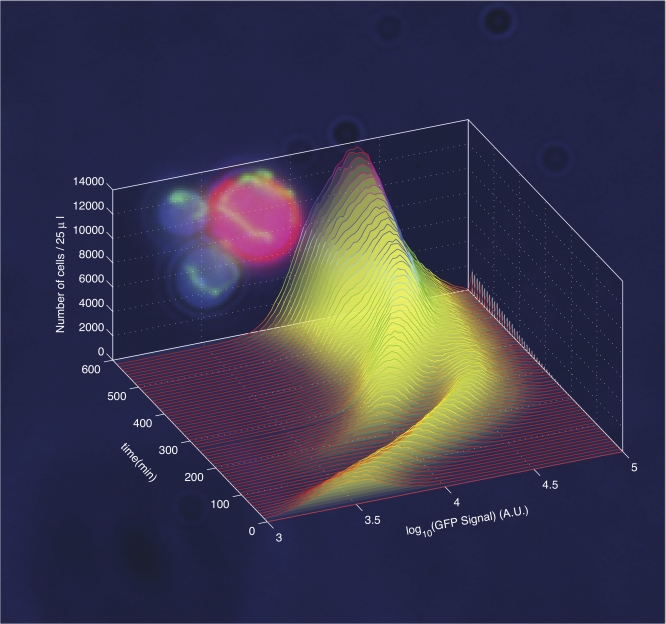
Dynamics of gene induction represented by a three-dimensional histogram. In response to leucine depletion, yeast cells produce GFP-tagged Leu1 protein, and the distribution of fluorescence shifts to the right. The shape of the distribution also changes as the population divides. The background is a microscopy image of these cells during cell division.